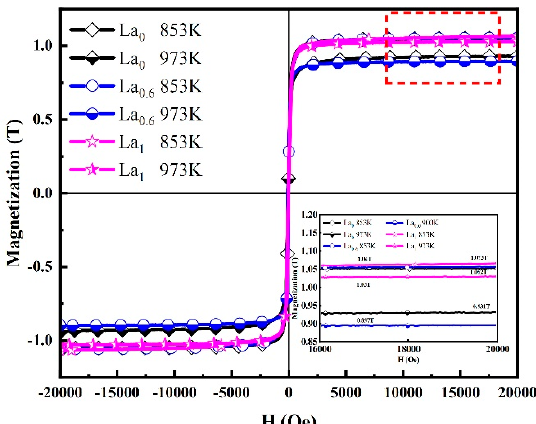
Figure 4. The M – H curves of Fe 27 Co 27 Ni 27 Si 10 − x B 9 La x ( x = 0, 0.6, 1) alloys annealed above the crystallization temperature.